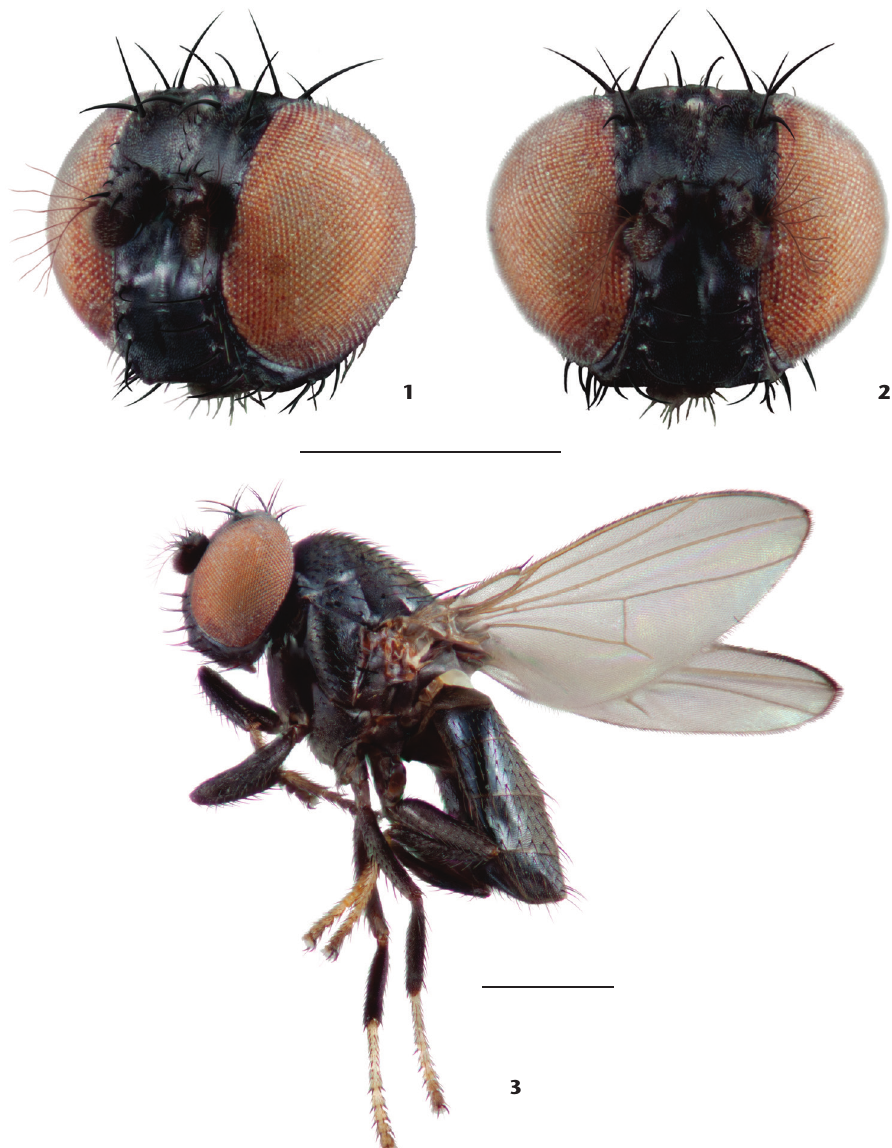
Figures 1-3. Photos of Orasiopa ( Reymontopa ) mera , male (Costa Rica. Puntaneras: Pochocal): (1) head, anterolateral oblique view; (2) same, anterior view; (3) habitus, lateral view. Scale bar: 0.5